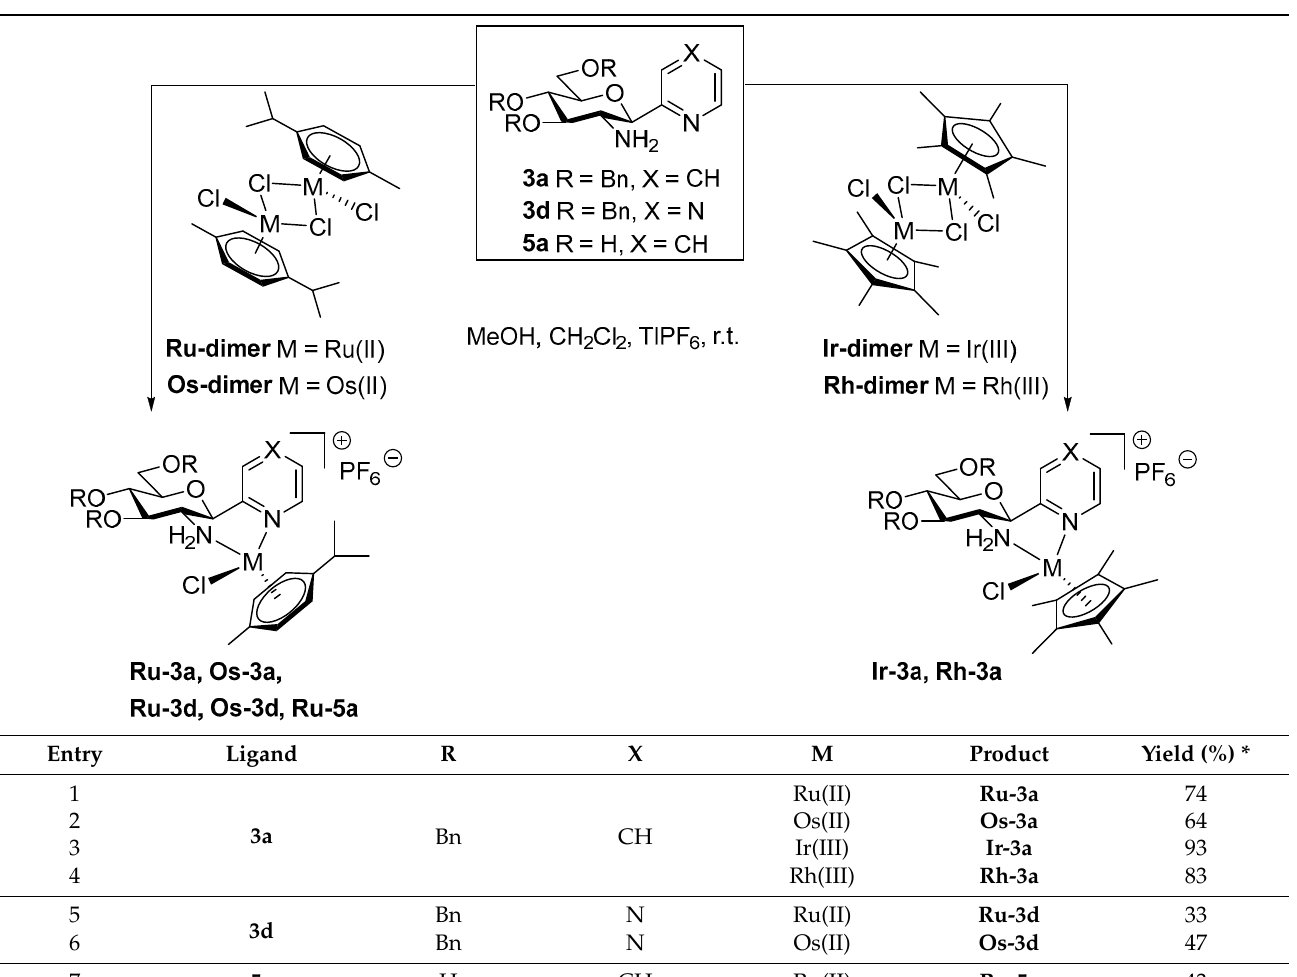
Table 4. Synthesis of half-sandwich platinum-group metal complexes with the O -perbenzylated and O -unprotected C -glucosaminyl azines.